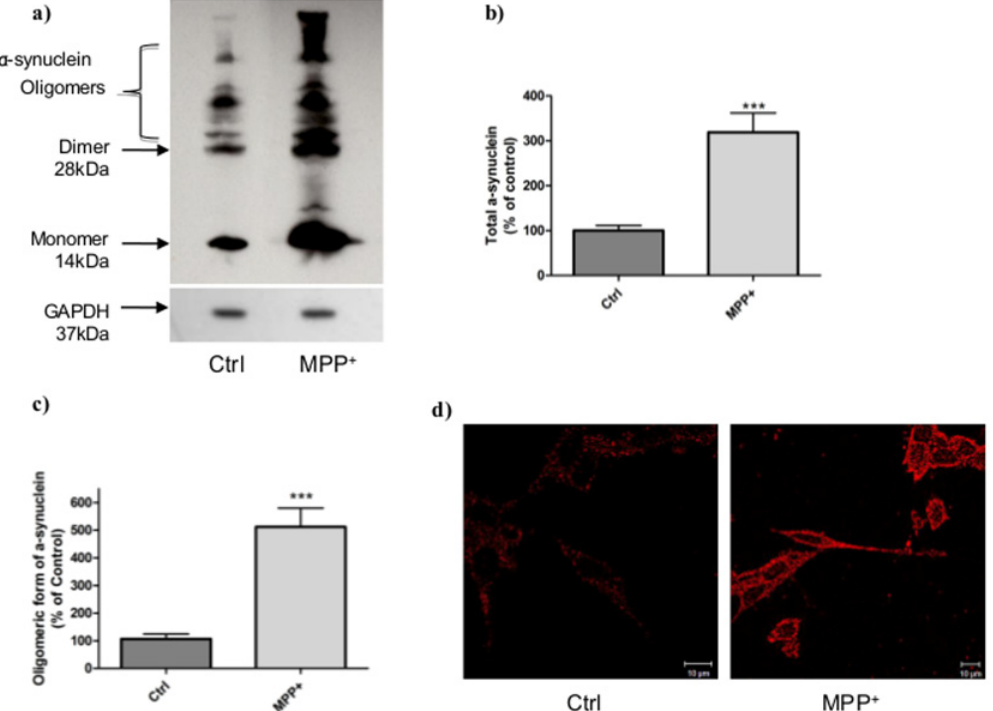
Figure 3. Characterization of α -synuclein aggregation in cells after MPP + stress. a) Typical immunoblot of α -synuclein in stressed (MPP + , 6h)) and unstressed (Ctrl) cells. b) Total and c) oligomeric forms of α -synuclein measured on stressed (MPP + ) and unstressed (Ctrl) cells by Western Blot and quantified by ImageJ software. This immunoblot represents three independent experiments and is expressed as the mean ± S.E.M. *** p < 0.01 compared to control cells. GAPDH was used as loading control. d) α -synuclein aggregation immunostaining with α -synuclein antibody in unstressed cells (Ctrl) and MPP + - stressed cells. Cells were observed with a confocal microscope Zeiss Axio Observer Z.1.